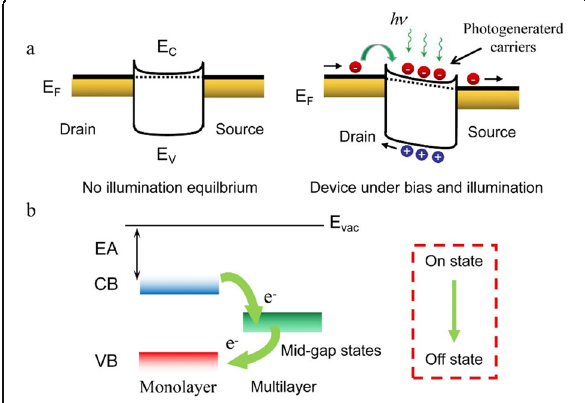
Fig. 4 Physical mechanism of multilayer Bi 2 O 2 Se – based photodetector. a The behavior of photo-generated charge carriers of multilayer Bi 2 O 2 Se-based photodetector. Here, E F is the Fermi level energy, E C is the minimum conduction band, E V is the maximum valence band. b The recombination process ( “ on ” state to “ off state ” ) of Bi 2 O 2 Se-based photodetector. Here, CB is conduction band, CV is valence band, E vac is vacuum energy, EA is electronic